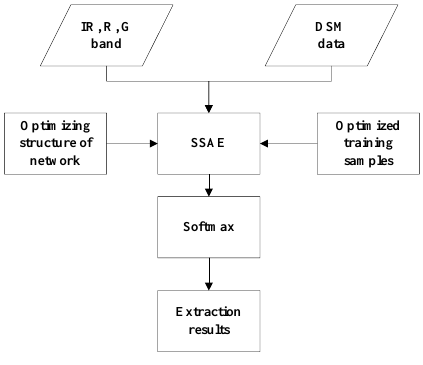
Figure 1. The framework of the building extraction method.